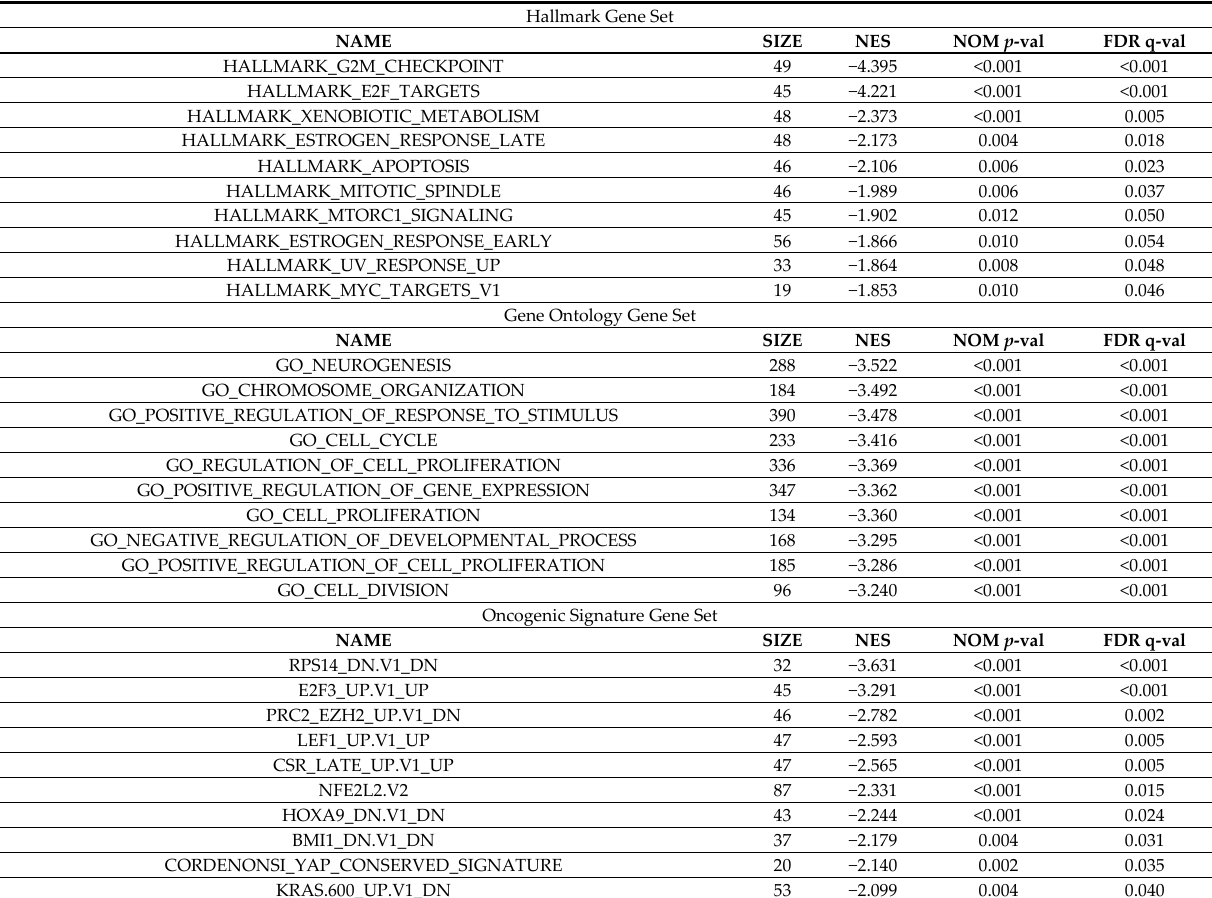
Table 1.– Significantly enriched gene sets for genes downregulated following CBX2 depletion using siCBX2#3 in MDA ‐ MB ‐ 231 cells. The 10 most significantly enriched gene sets from the Hallmark, Gene Ontology, and Oncogenic signature curated gene set database are shown. Gene sets are inversely ranked by normalised enrichment score (NES). SIZE = number of differentially expressed genes enriched in